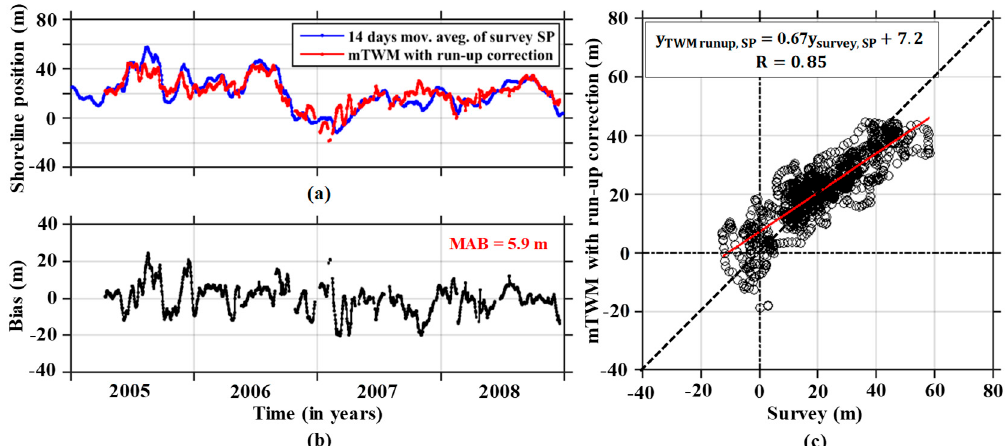
Figure 21. ( a ) The temporal variations in shoreline positions (SP) estimated from the survey data and mTWM-derived results with corrected wave run-up (at x = − 49 m). ( b ) The estimated bias between the survey data and mTWM-derived results with corrected wave run-up. ( c ) The scatter plot of the survey data vs. mTWM-derived results with corrected wave run-up. The red line represents the linear fitting line.